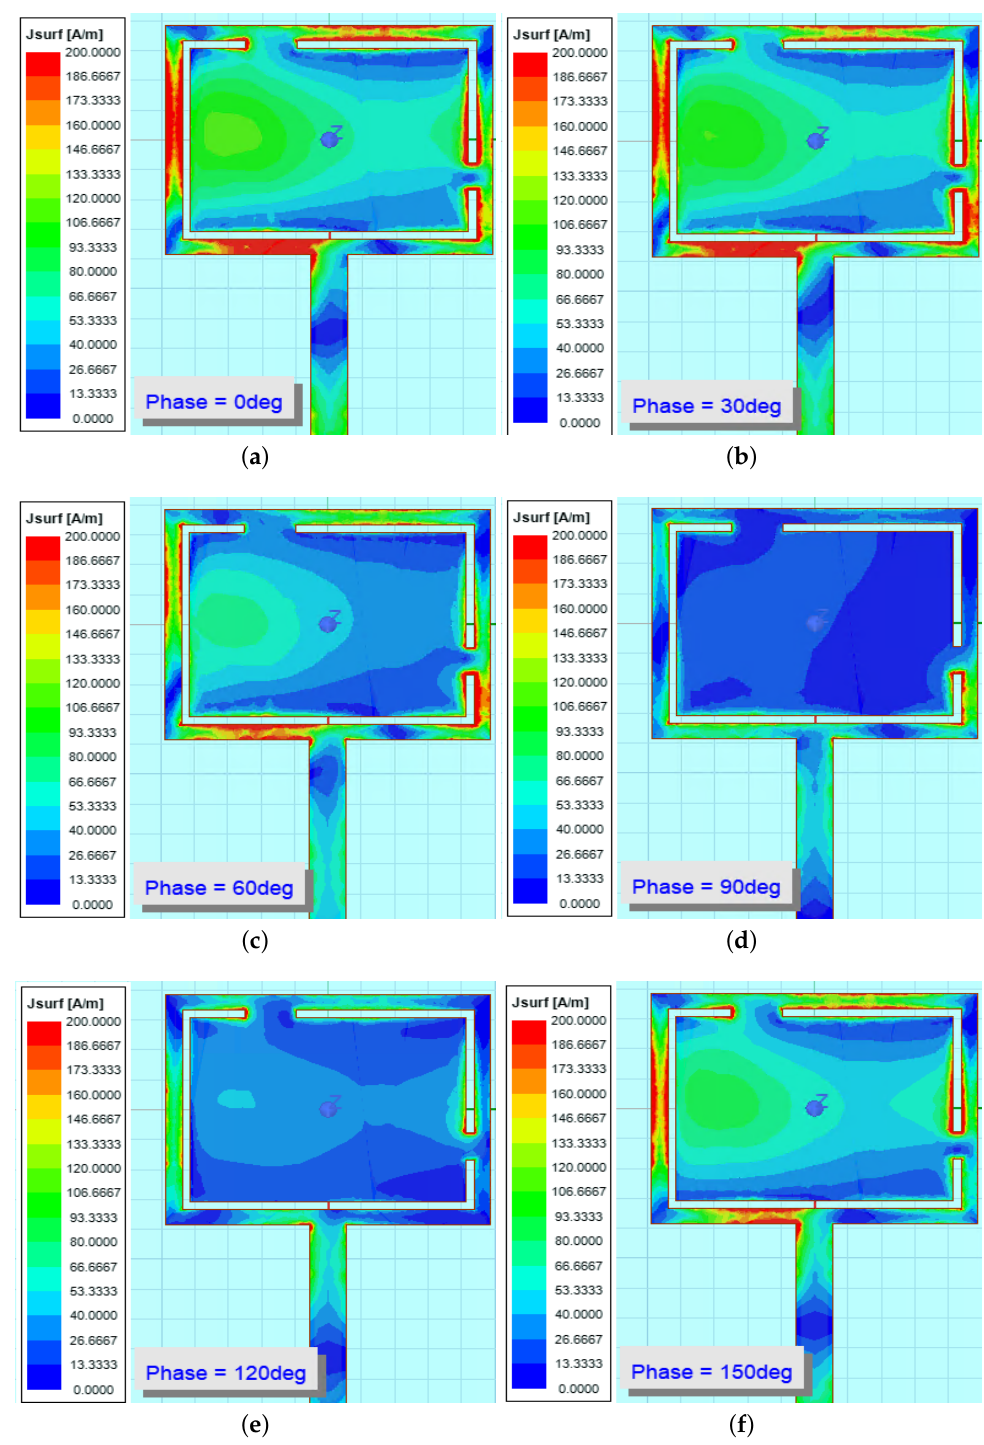
Figure 16. Surface current distribution at 5.8 GHz for cylinder radius of 50 mm. ( a ) 0 degrees; ( b ) 30 degrees; ( c ) 60 degrees; ( d ) 90 degrees; ( e ) 120 degrees; and ( f ) 150